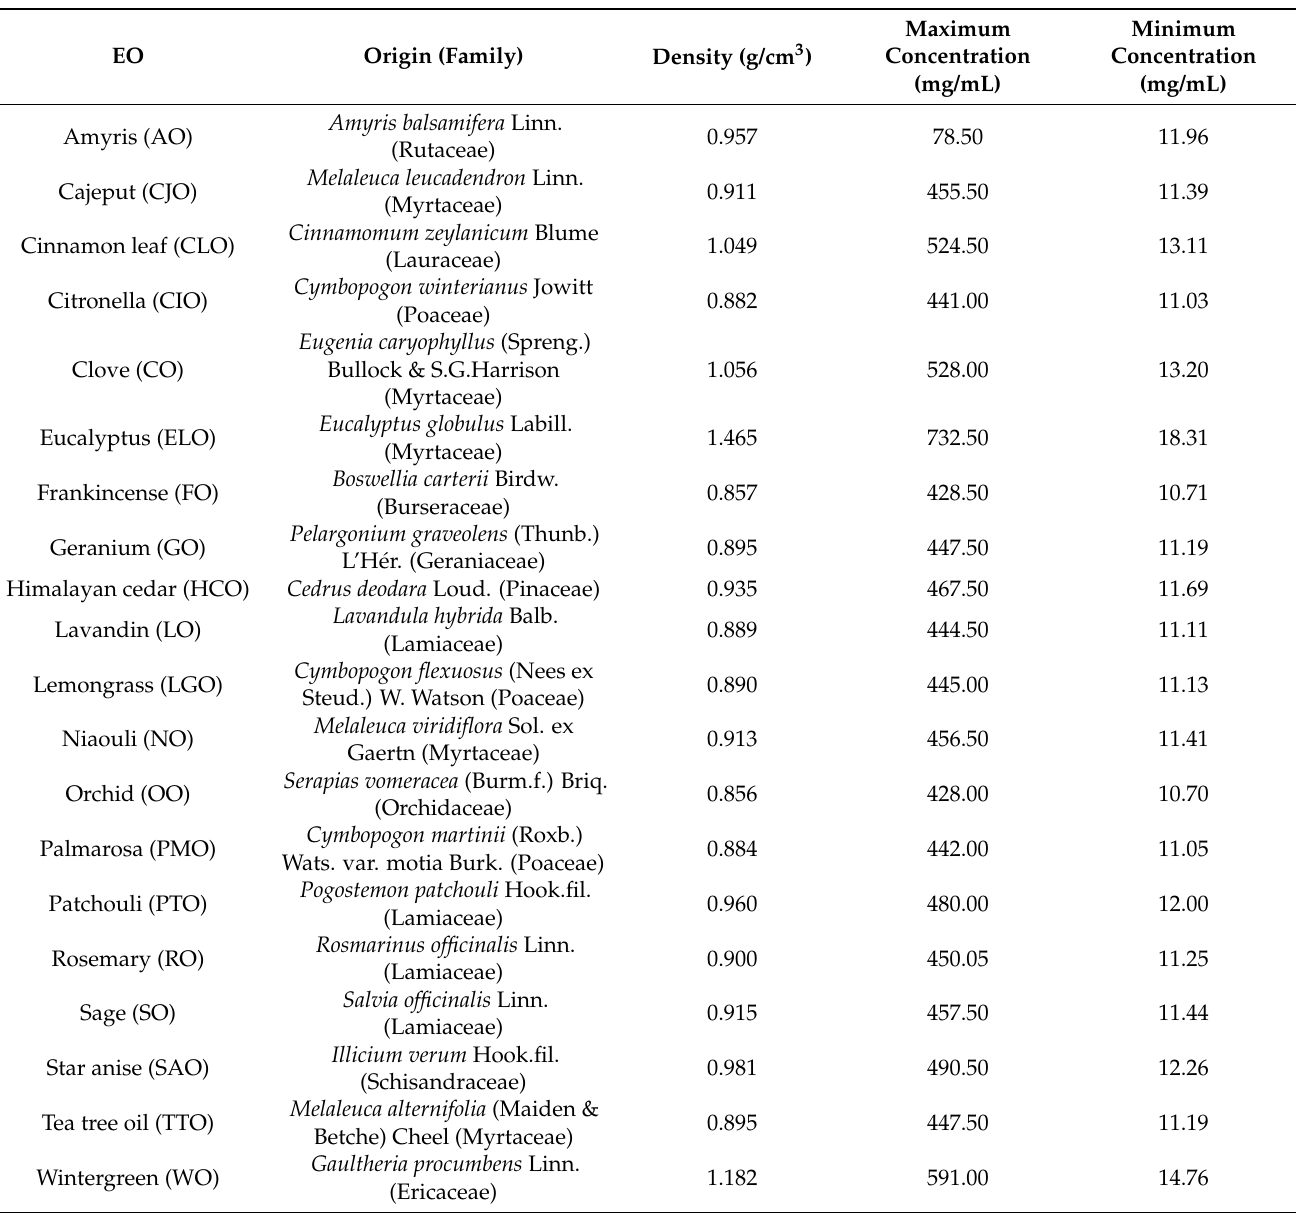
Table 1. List of tested EOs (all extracted via azeotropic distillation processes), their origin and density, as well as maximum (50% v / v ) and minimum (1.25% v / v ) tested